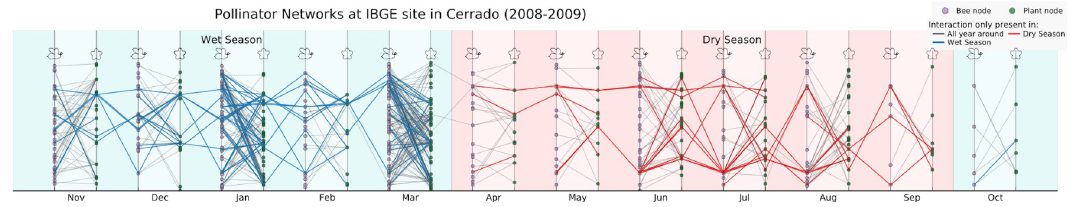
Fig 4. Turnover in monthly bee pollinator networks from Oct 2008 to Sep 2009. Every node in a monthly network represents a distinct plant or bee species. Each link between plant and bee nodes represent a unique pollination visit in the corresponding month. Links between monthly networks show interactions recorded in both monthly networks. Background of plot is color-coded to reflect the seasons: blue–rainy season; red—dry season. Lighter shaded areas demarcate the pollinator networks of each month, while darker areas demarcate the links present between monthly networks.